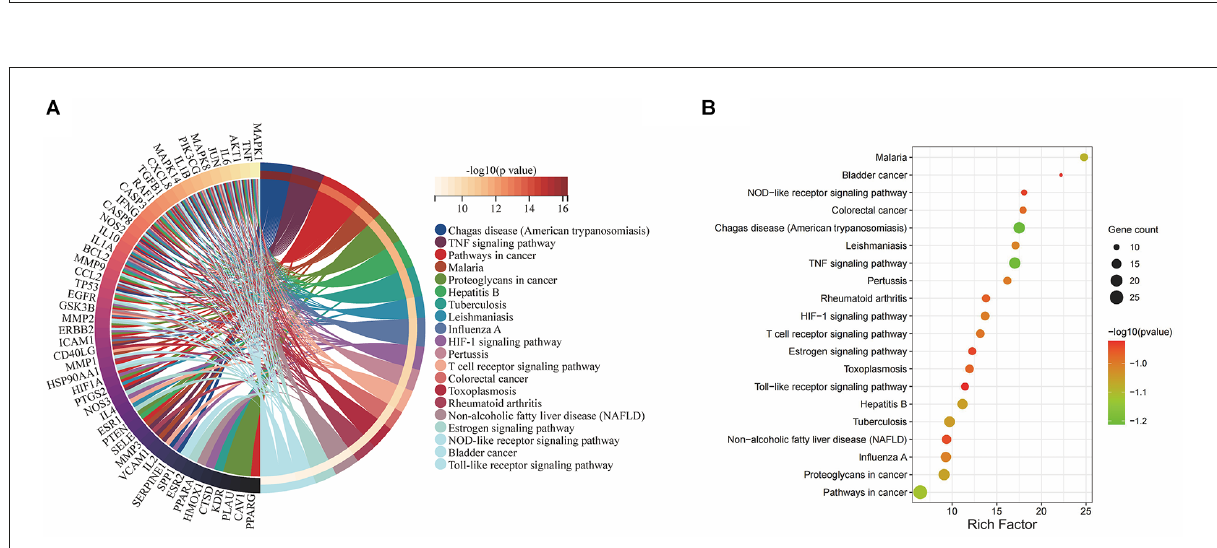
FIGURE7 KEGG pathway enrichment analysis. (A) The top 20 items ranked by − log10(p) value is shown by the Circro diagrams. (B) The top 20 items ranked by − log10(p) value, gene count, and rich factor are shown by the bubble